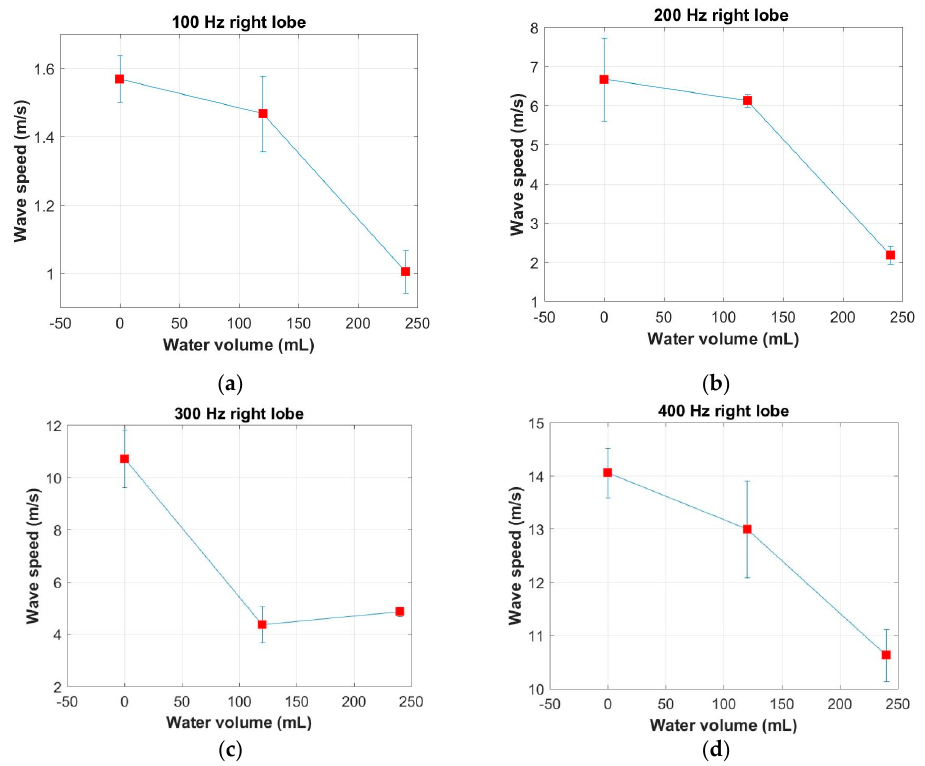
Figure 4. Measurements of surface wave speeds with water volume on the right lobe of the lung. ( a ) 100 Hz, ( b ) 200 Hz, ( c ) 300 Hz, and ( d ) 400 Hz. Appl. Sci. 2019 , 9 , x FOR PEER REVIEW